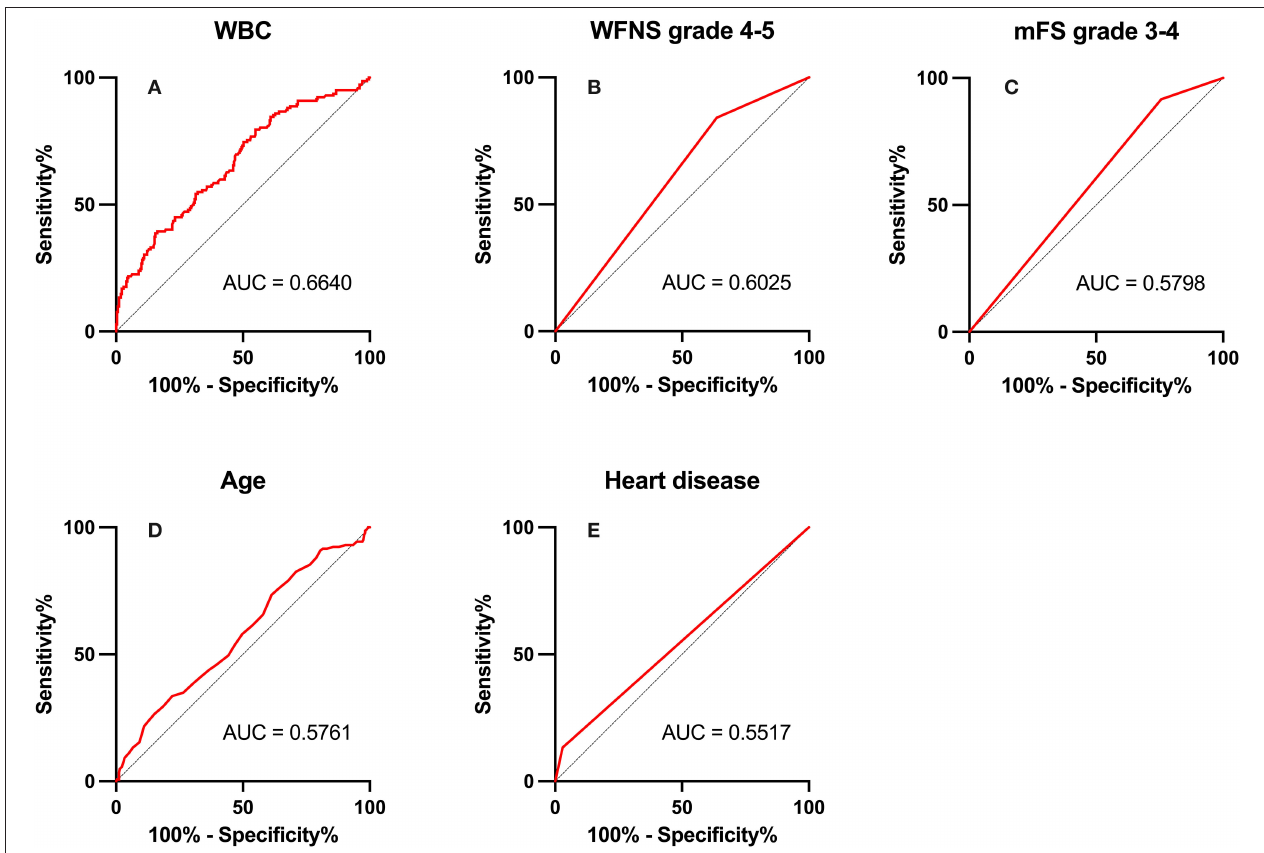
FIGURE 3 | Area under the receiver operating characteristic (AUC) values for preoperative factors that predicted postoperative pneumonia in the surgical clipping (SC) group. (A) White blood count (WBC; AUC = 0.664, 95% CI = 1.07–1.20; p < 0.001). (B) World Federation of Neurosurgical Societies (WFNS) grade 4–5 (AUC = 0.603, 95% CI = 1.03–3.00; p = 0.037). (C) Modified Fisher Scale (mFS) grade 3–4 (AUC = 0.580, 95% CI = 1.15–4.77; p = 0.019). (D) Age (AUC = 0.576, 95% CI = 1.01–1.05; p = 0.015). (E) Heart disease (AUC = 0.552, 95% CI = 2.03–12.45; p <